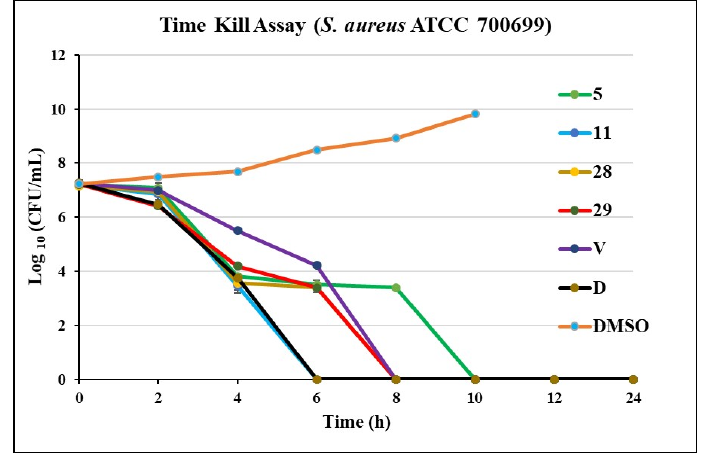
Figure 3. Time Kill Assay of potent compounds 5 , 11 , 28 , and 29 against an MRSA ( S. aureus ATCC 700699), Vancomycin ( V ), and Daptomycin ( D ) are positive controls. All compounds, including positive controls, were tested at a 4× MIC concentration.